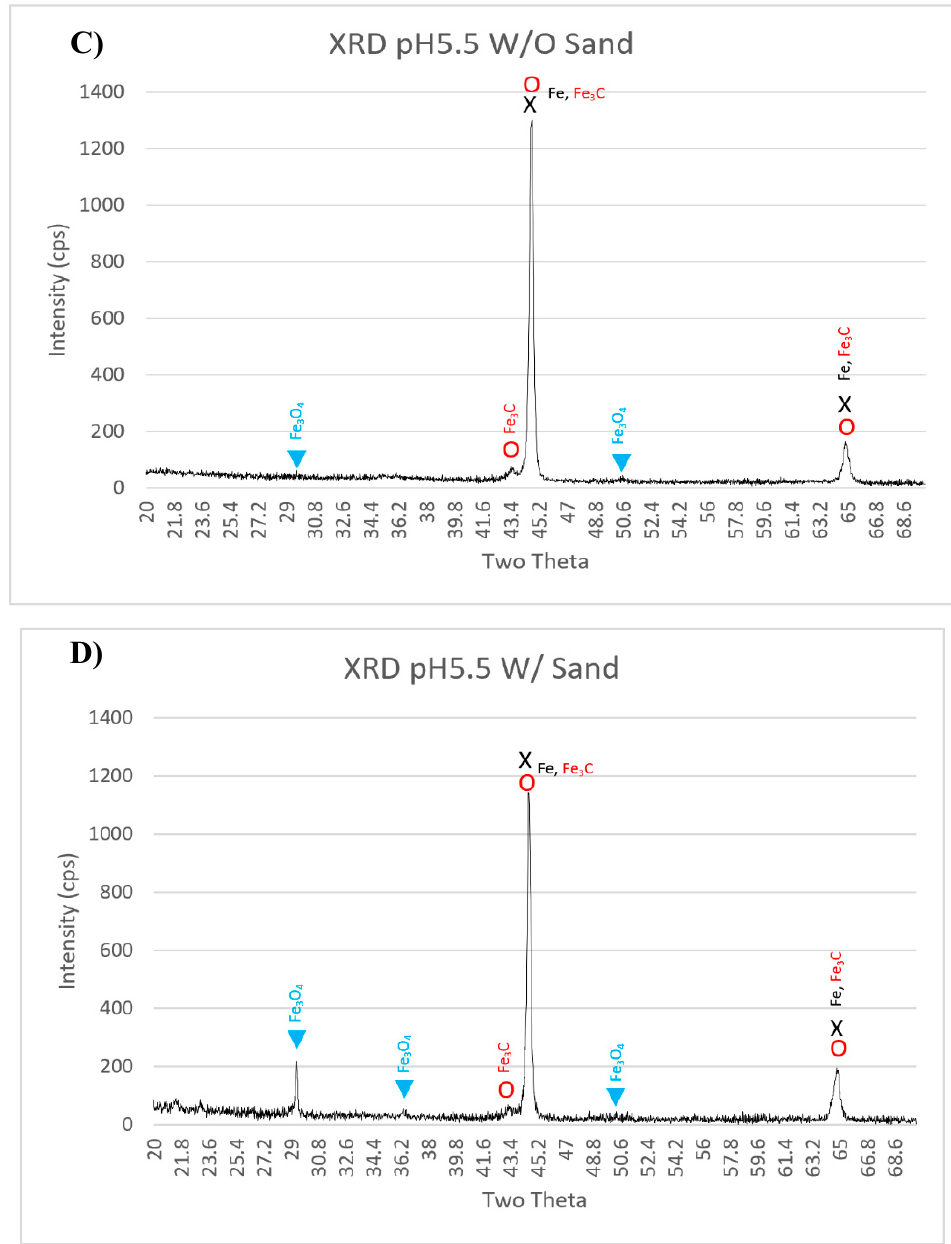
Figure 5. XRD peaks for API 5L X65 tested in CO 2 IC API 5l X65 tested in CO 2 EC at impingement angle 90°, room temperature, impingement velocity 8 m/s: ( a ) pH 4.5 without sand, ( b ) pH 5.0 without sand, ( c ) pH 5.5 without sand, and ( d ) pH 5.5 with sand.